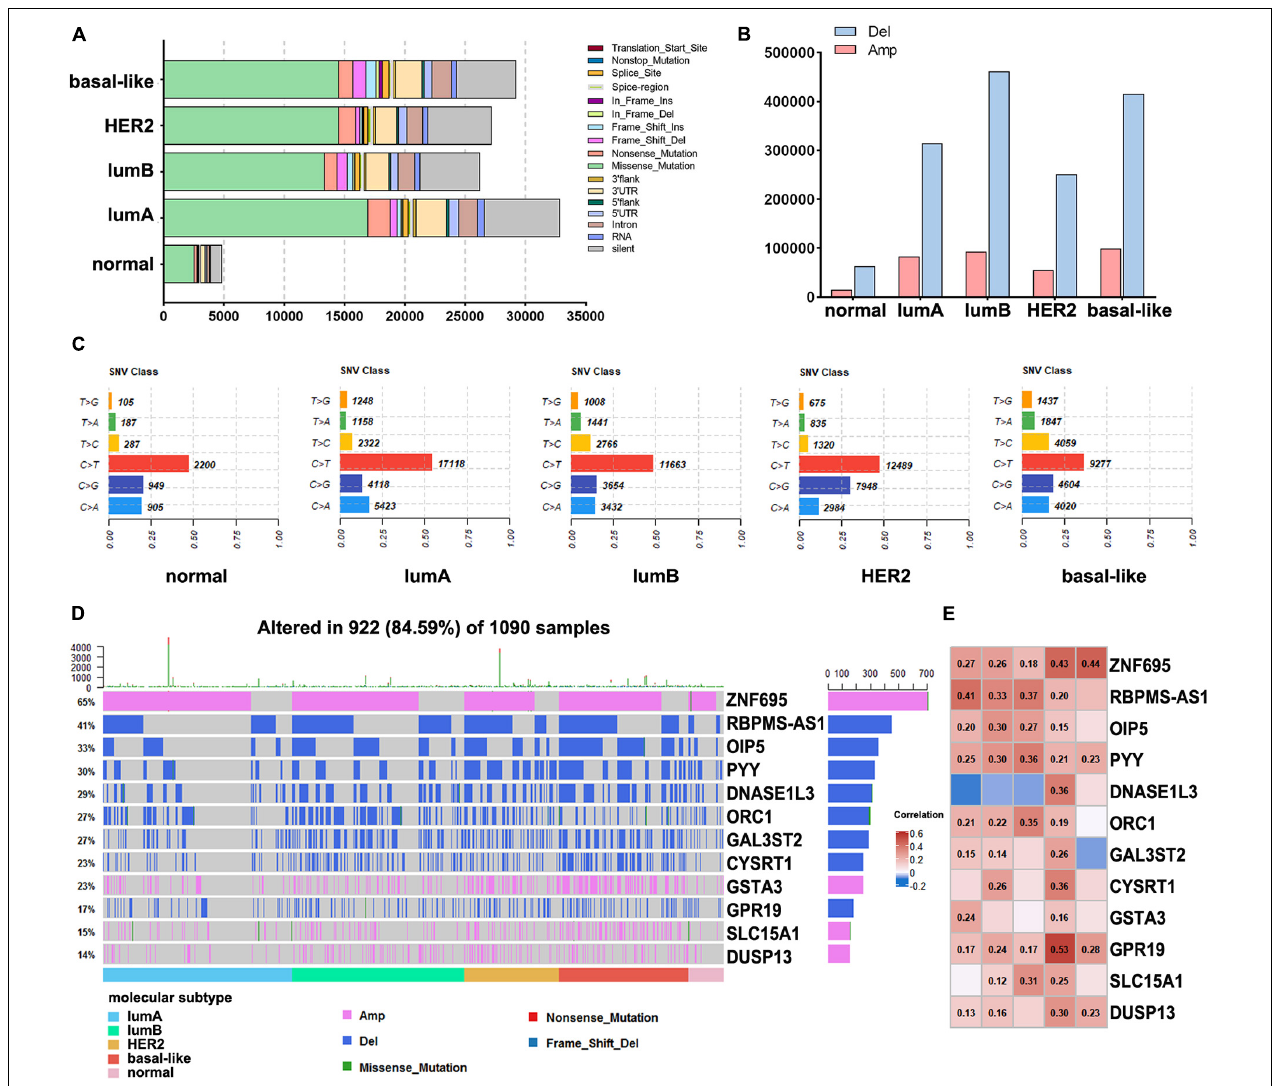
FIGURE 3 | Analysis of DNA alterations in different breast cancer subtypes. (A) The different classified categories of DNA mutations in each breast cancer subtype. (B) The number of copy number variations in each subtype. (C) Statistics of SNV changes in different subtypes. (D) Waterfall chart showing the mutations of different subtype-specific genes. (E) Correlation analysis of subtype-specific RNAs and their modifications in different subtypes. The numbers in the figure are correlation coefficients, a negative value represents a negative correlation, and a positive value represents a positive correlation.